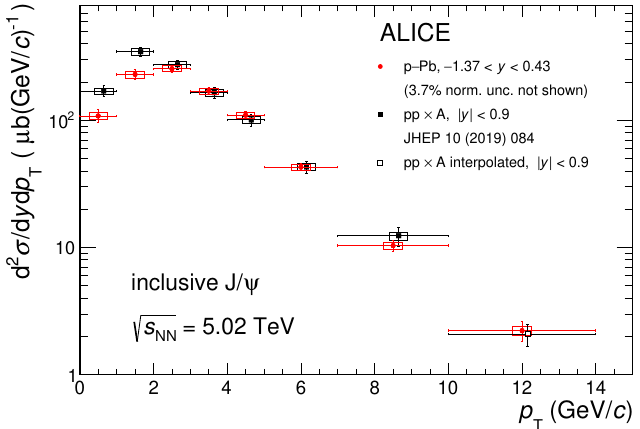
Figure 3 . The p -differential inclusive J /ψ cross section per unit of rapidity, d 2 σ T a function of p in p-Pb collisions (red circles) compared with the analogous cross section measured T √ in pp collisions at s = 5 . 02 TeV [7] multiplied by the Pb mass number ( A = 208 ) (black closed squares, shifted horizontally by 150 MeV/ c for better visibility). The vertical error bar and the box on top of each point represent the statistical and systematic uncertainty, respectively. The open square symbol (also shifted by 150 MeV/ c ) shows the value for pp collisions in the p 10-14 GeV/ c , which was obtained with the interpolation procedure. In this case the error bar corresponds to the total